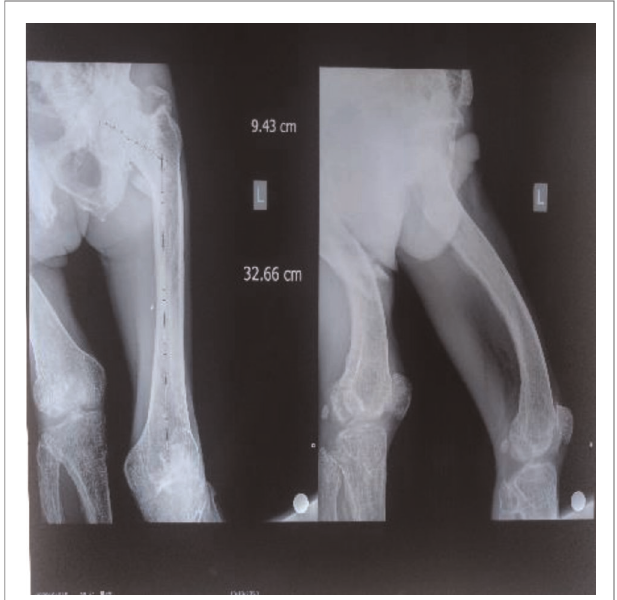
FIGURE 2 | Preoperative external image. FIGURE 4 | Preoperative imaging of the unaffected